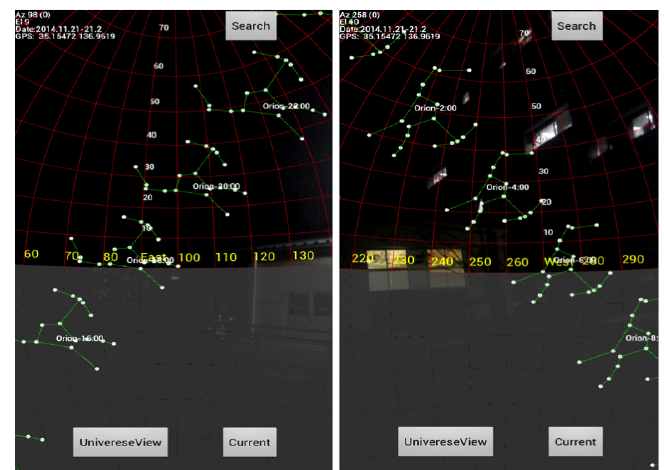
Figure 7. The AR display of the orbit of Orion over one day in AR view.